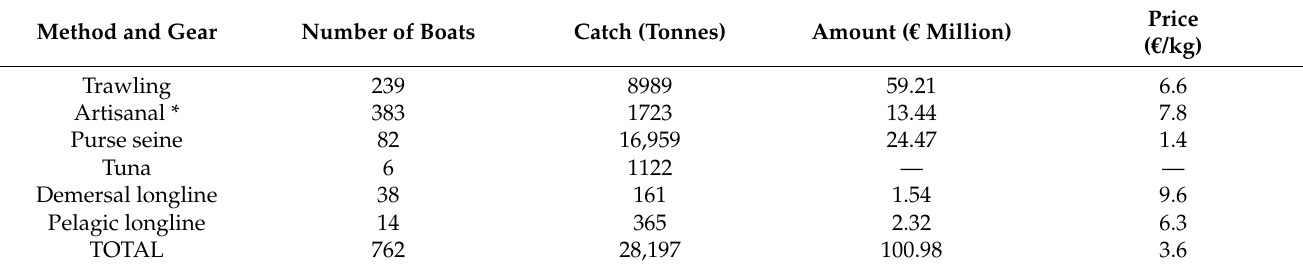
Table 6. Professional fishing in Catalonia